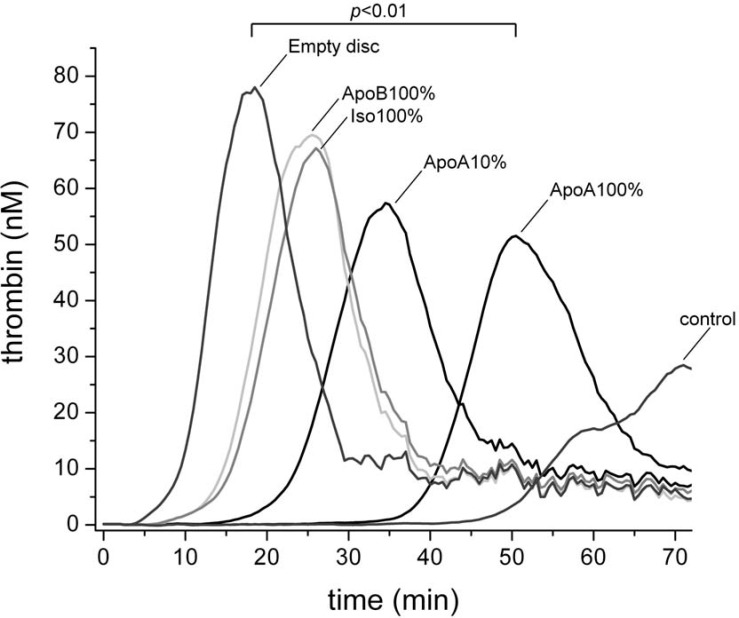
Thrombin generation on coated discs.Thrombin generation for discs coated with either ApoA-I-, ApoB-, Isotype- or no antibody (empty discs), compared to thrombin generation in absence of a disc (negative control). (n = 4).